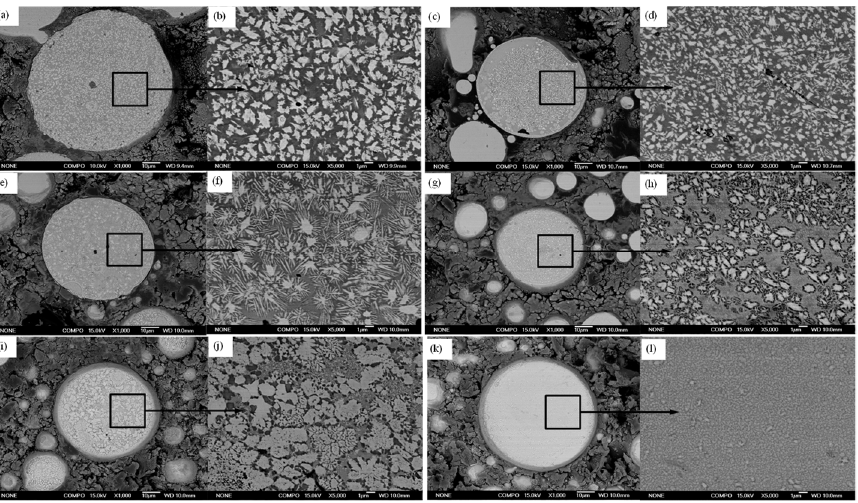
Figure 2. Microstructure of the particles with different compositions (SEM). ( a ),( b ) Sample 1; ( c ),( d ) Sample 2; ( e ),( f ) Sample 3; ( g ),( h ) Sample 4; ( i ),( j ) Sample 5; ( k ),( l ) Sample 6